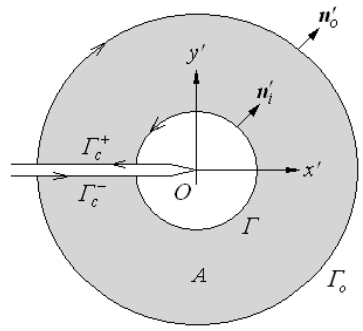
Figure 2. An extension of contour Γ and a donut-type domain of integration A